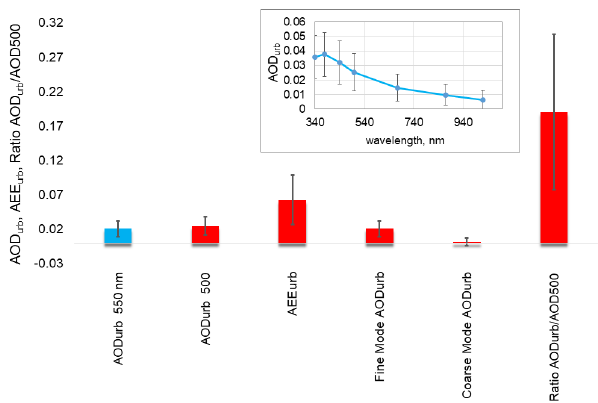
Figure 8. Annual mean urban components of different aerosol parameters – AOD urb at 550 and 500nm, fine-mode AOD urb , coarse-mode AOD urb , urban component of AEE urb and AO- Durb / AOD500 ratio with confidence intervals at the 0.05 signif- icance level. The inset shows the mean AOD urb spectral depen- dence. Comment: we show the AOD at two wavelengths to provide more convenient comparisons with the CIMEL sun-photometer ob- servations (AOD at 500nm) and model results (AOD at 550nm). Moscow.